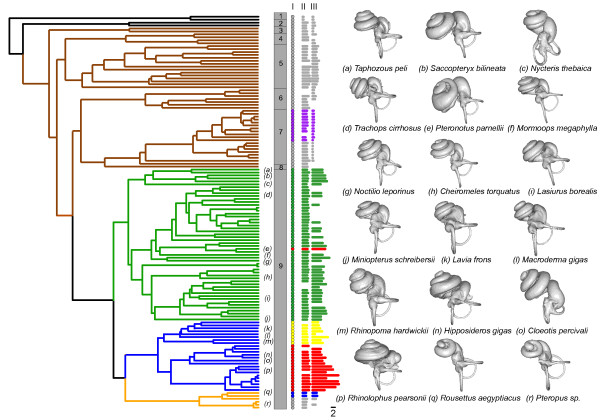
Phylogeny of the study species with key characters mapped. Characters are coded as follows: (I) echolocation type: broadband (yellow); constant frequency (red); FM (green); none (grey); tongue-clicks (blue); non-laryngeal echolocation (purple); (II) number of cochlear turns and (III) relative basilar membrane length. Clades are numbered as follows: (1) monotremes; (2) marsupials; (3) Afrotheria; (4) Primates; (5) Glires; (6) Carnivora; (7) Cetartiodactyla; (8) Perissodactyla; (9) Chiroptera. Branch colours indicate: Monotremes and marsupials (black); Non-bat placental mammals (brown); Yangochiroptera (green); echolocating Yinpterochiroptera (blue); non-echolocating Old World fruit bats (Pteropodidae) (orange). Representative examples of cochlear reconstructions for 18 species (a-r) are shown.